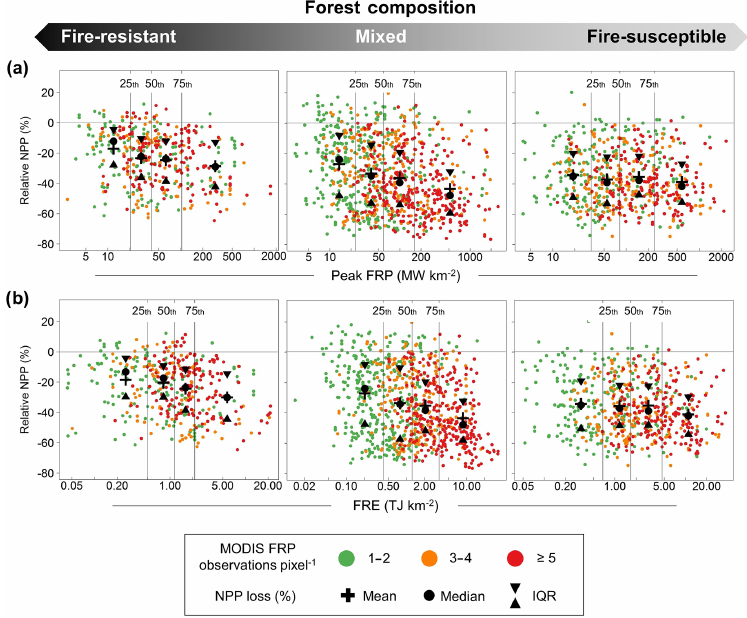
Figure 3. Fire intensity impacts on 1-year post-fire NPP observed in forests dominated by species varying from fire-resistant to fire- susceptible (first column–third column). Distributional statistics are shown for NPP grouped by (a) peak FRP percentile class and (b) FRE percentile